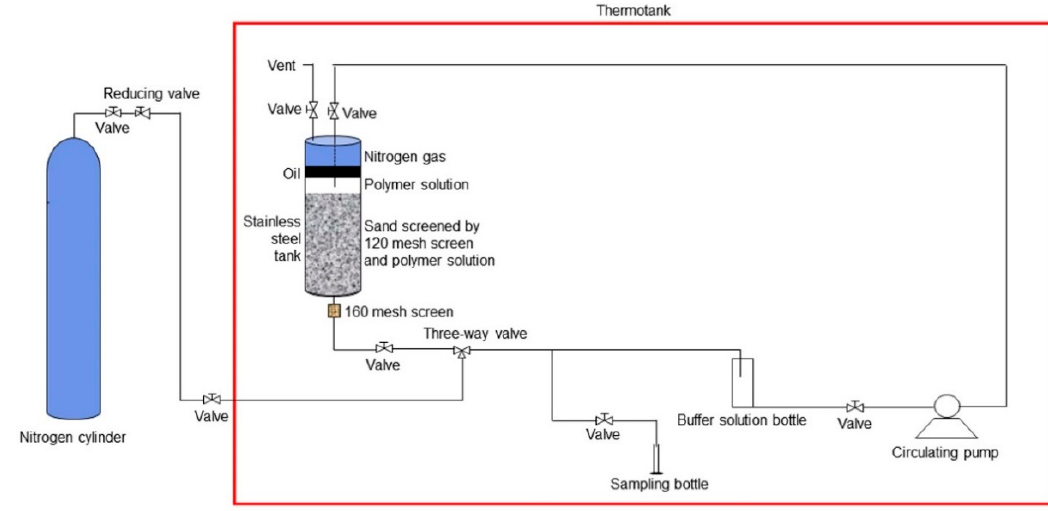
Figure 1. The schematic of a polymer dynamic degradation experiment.